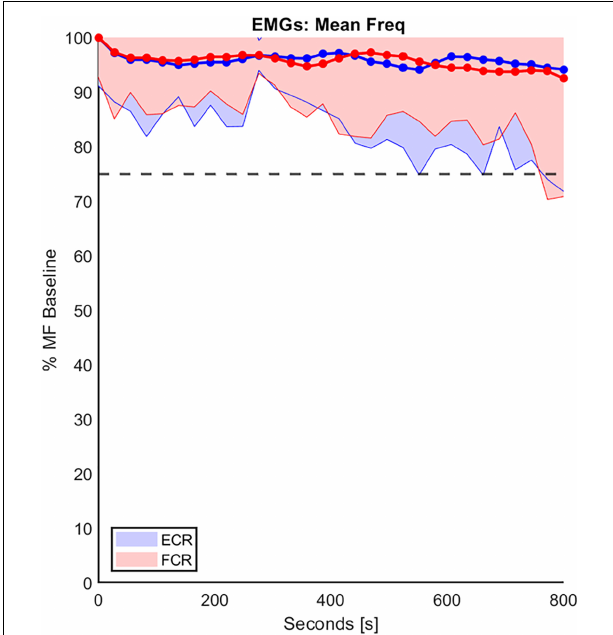
FIGURE 4 | The trend of the percentage decline of the mean frequency (MF) of both FCR and ECR (red and blue, respectively), over the duration of the experiment protocol in the RH group. The MF values were normalizated to the corresponding baseline MF performed on the first day of experimentation. These data were averaged on the entire population and the standard deviation (shaded part) is provide. The horizontal line represents the 25% threshold used in this work to be considered a fatigue cut-off.